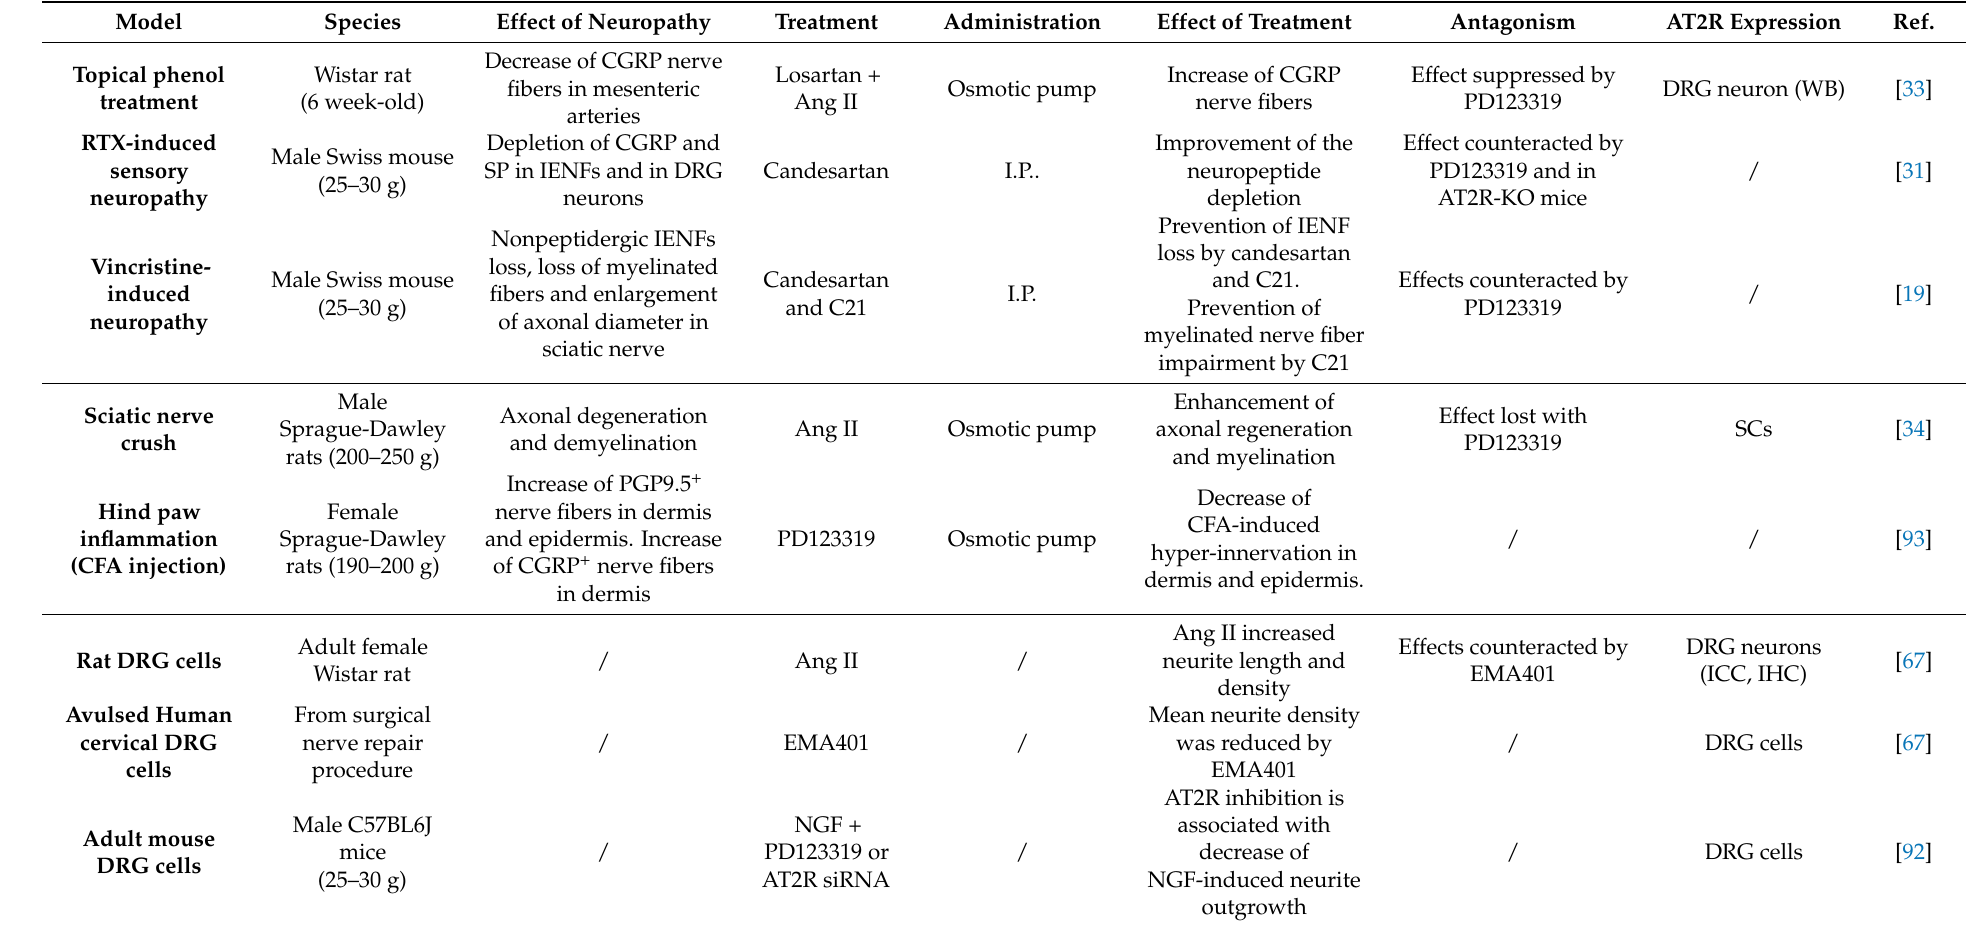
Table 1. Neuroprotective and neuroregenerative effect of AT2R stimulation in the peripheral nervous